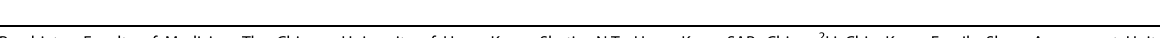
baseline (Fig. 1: fl owchart of the study). Demographic character- istics and personality traits of all subjects were shown in Table 1. The baseline age and sex were comparable between iRBD patients and controls (median [interquartile range, IQR] of age: 64.0 [12.0] vs. 66.0 [13.0] years, Z score = − 0.74, p = 0.46, r = 0.045; male